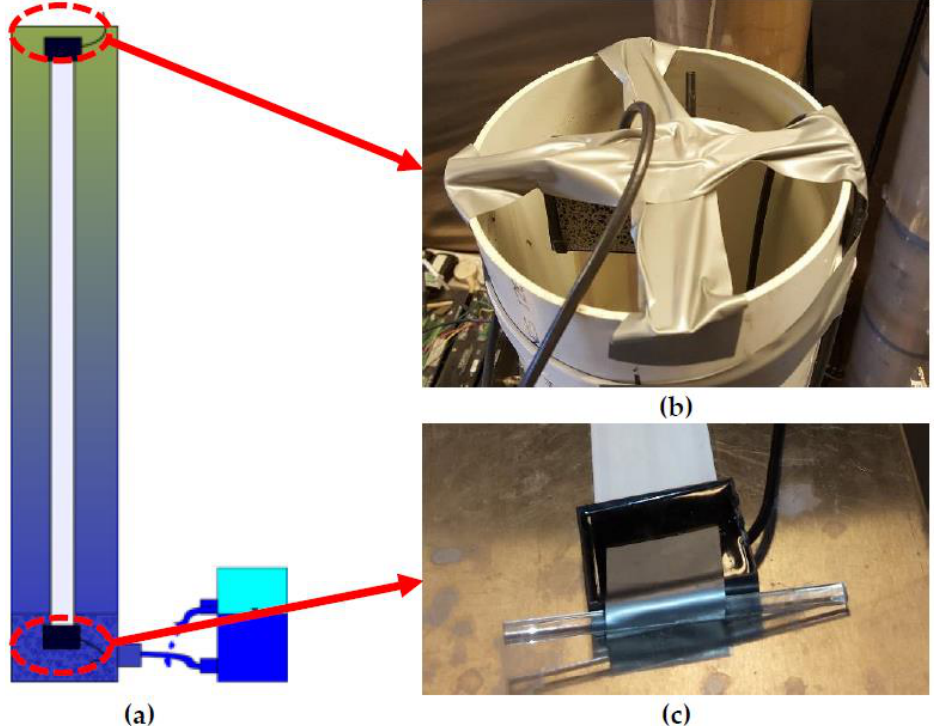
Figure 13. The central-located sensor installation method: ( a ) a demo of a central-located FRC in a soil column and the sensor bottom end is fixed by a gravel filter; ( b ) a cross holder fixing the sensor top end at the empty column top; ( c ) a rod attached to the sensor bottom end embedded in the filter.